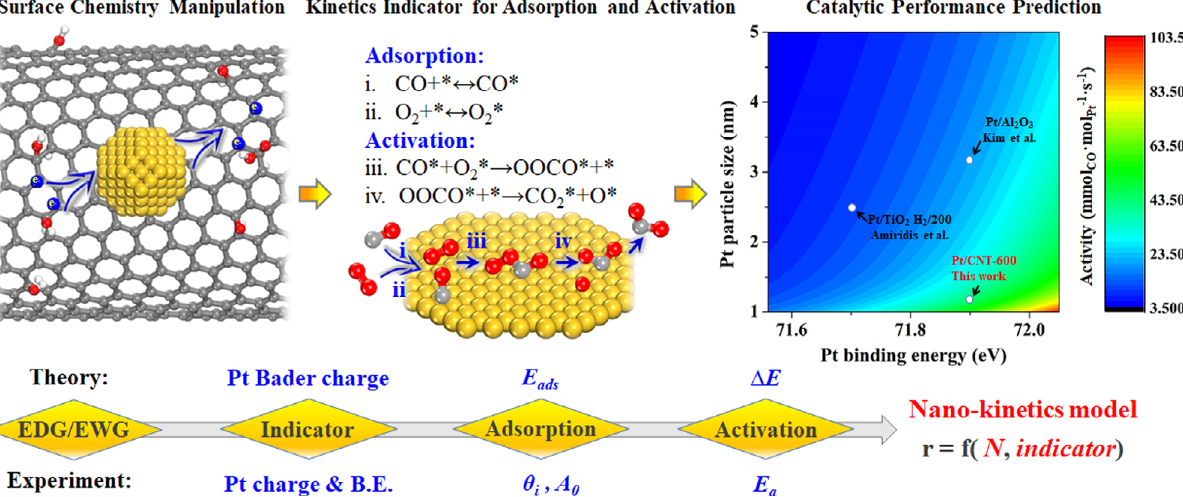
Fig. 6 Model derivation of CO oxidation. Schematic diagram of model derivation for Pt-catalyzed CO oxidation based on theoretical calculations and experimental